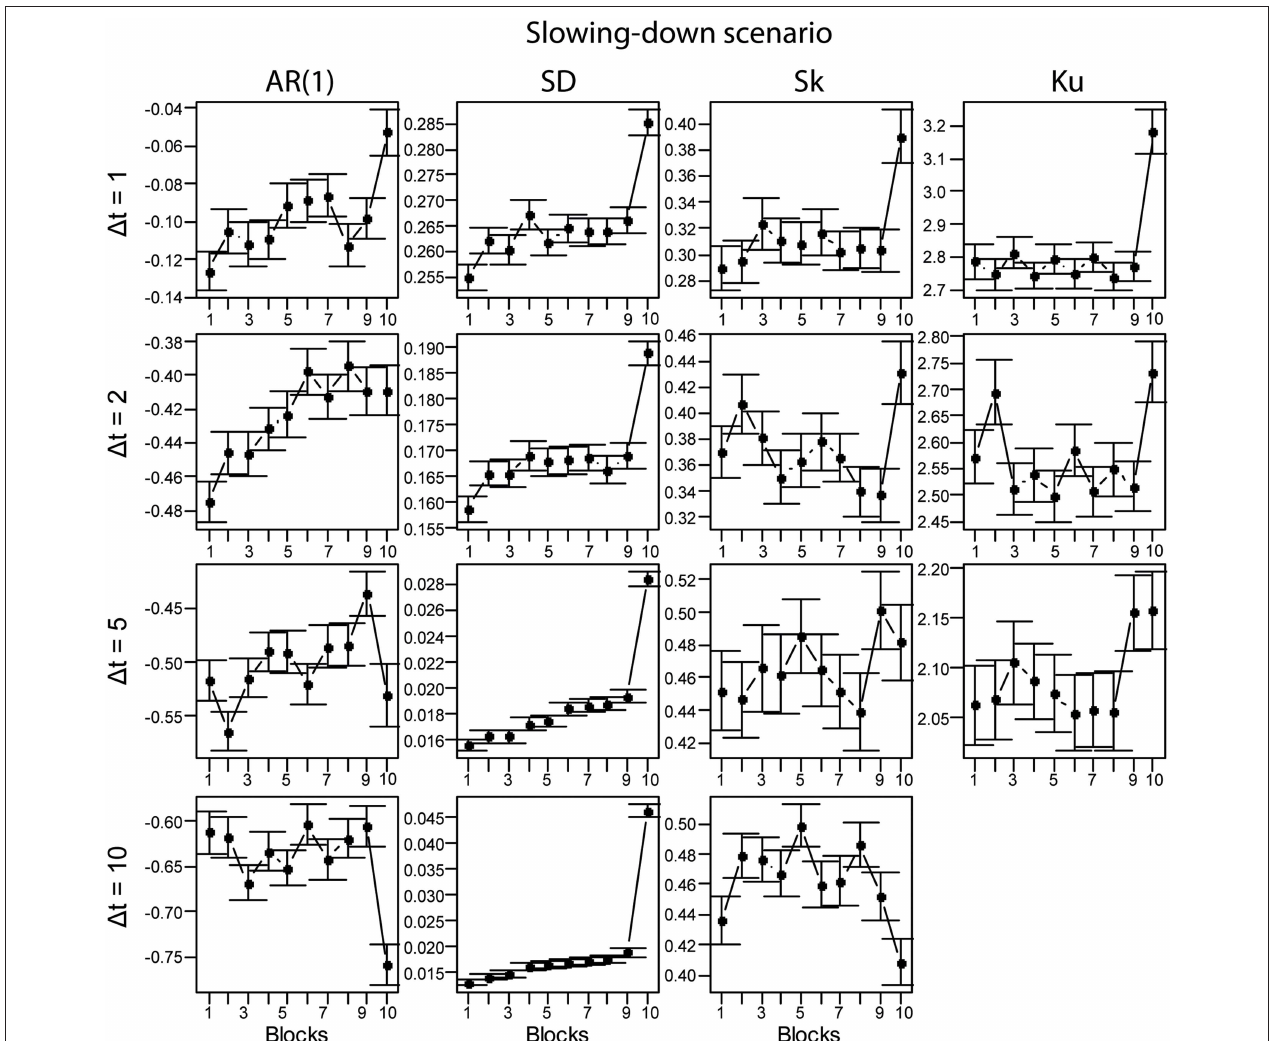
FIGURE 2 | Patterns of four EWSs for the slowing-down scenario from 200 simulated time series using the block-based approach. Time aggregation ranged from 1 t = 1 to 1 t = 10. Black circles associated with whiskers represent mean values and standard errors of EWSs. As time scale is reversed, the transition occurs at the end of the 10th block. AR(1), autocorrelation; SD, standard deviation; Sk, skewness; Ku, kurtosis. Kurtosis could not be computed for aggregation 1 = 10 because of the lack of data for each block ( n = 3 ) for this aggregation